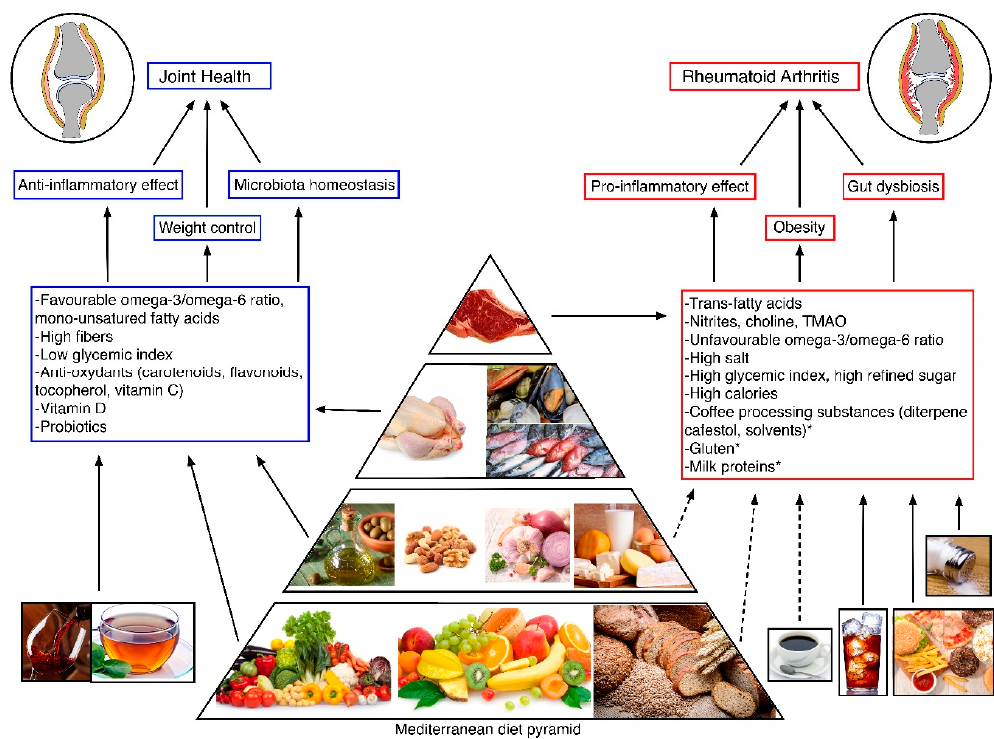
Figure 2: Nutrients and their food sources involved in the development and progression of Rheumatoid Arthritis. *Nutrients with less defined evidence. TMAO: trimethylamine-N-oxide